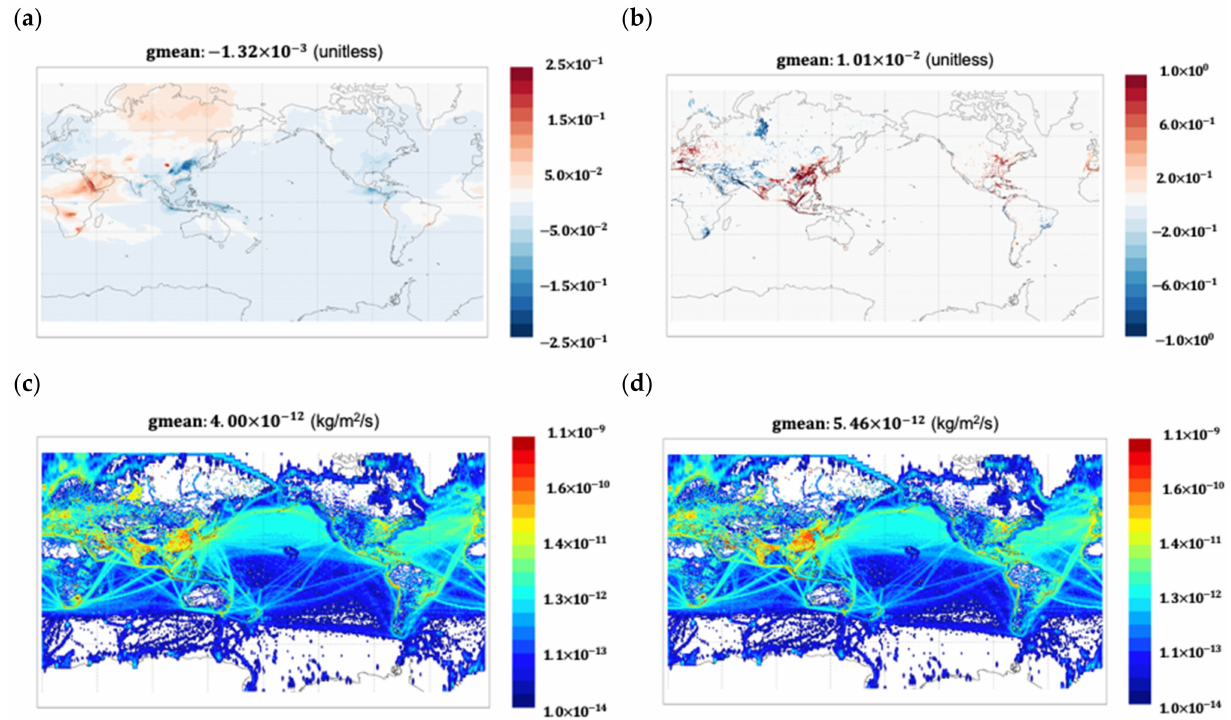
Figure 5. The differences in GEFS sulfate AOD from ( a ) MERRA2 sulfate AOD and ( b ) the fractional differences in SO 2 emissions, x-1 , in October 2021. A comparison of global SO 2 emissions between ( c ) CEDS 2019 and ( d ) after scaling